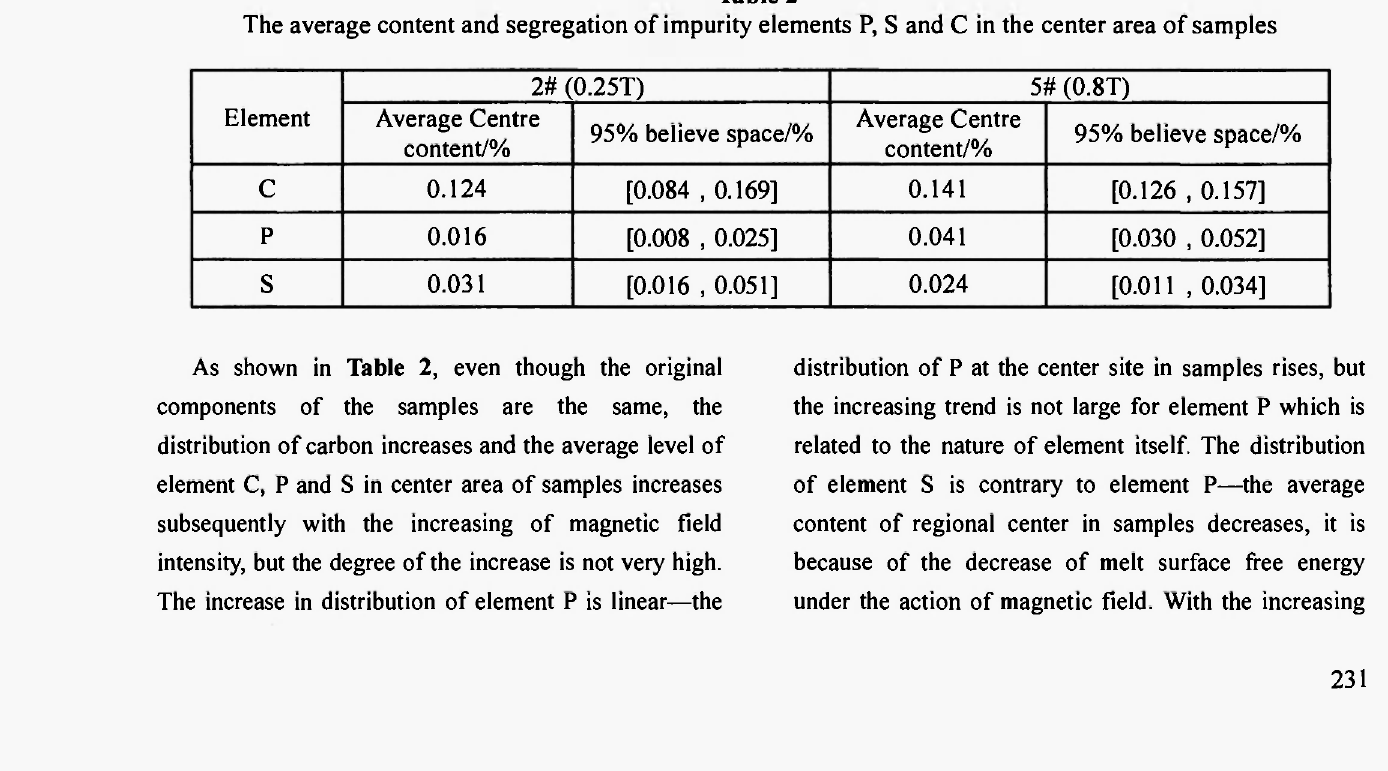
Fig. 6b: 3-dimensional diagrams of content distribution of element S (Sample processed by 0.25T in left and 0.8T in right) average content of S reaches a minimum of 0.024% in the scanning center for the sample processed by 0.8T, the peak-shape compresses, and the distribution of the average levels is still uneven.